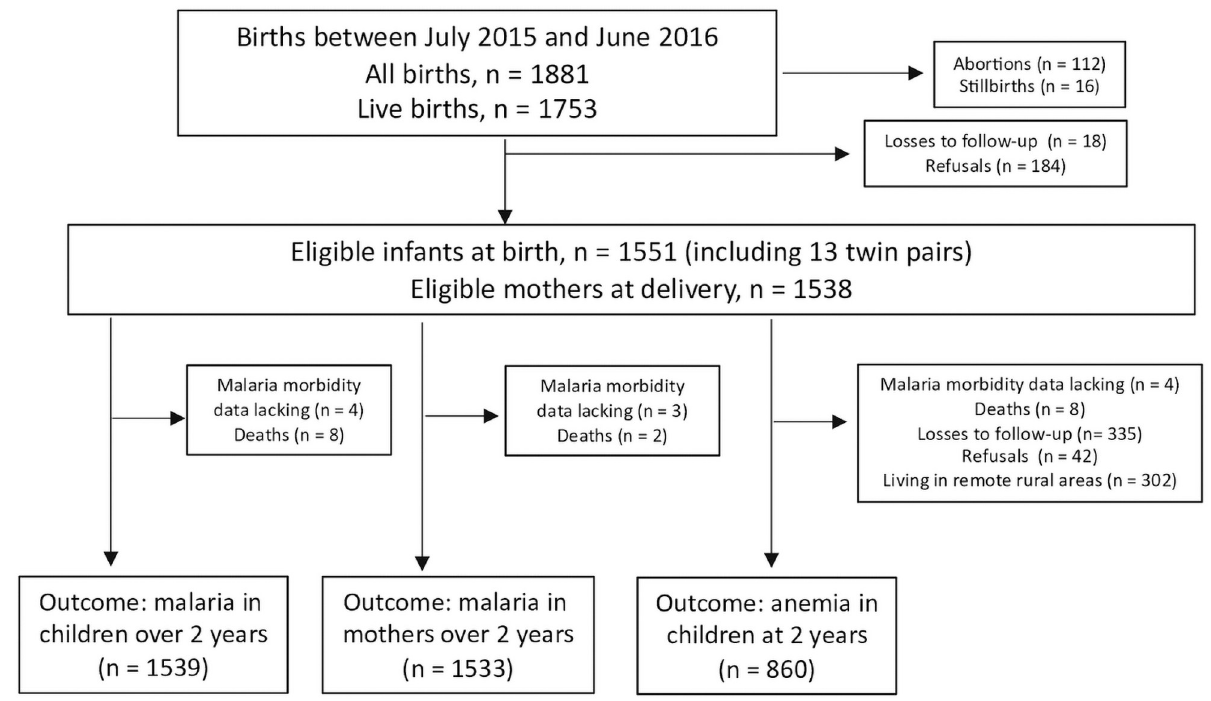
Fig 2. Study flowchart. Between July 2015 and June 2016, pregnant women attending antenatal clinics or admitted for delivery to the maternity ward of the Women and Children’s Hospital of Jurua´ Valley in Cruzeiro do Sul, Brazil, were invited to participate. Reasons for exclusion and the final number of subjects analyzed for each study outcome are